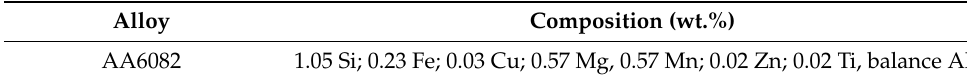
Table 3. Substrate composition.